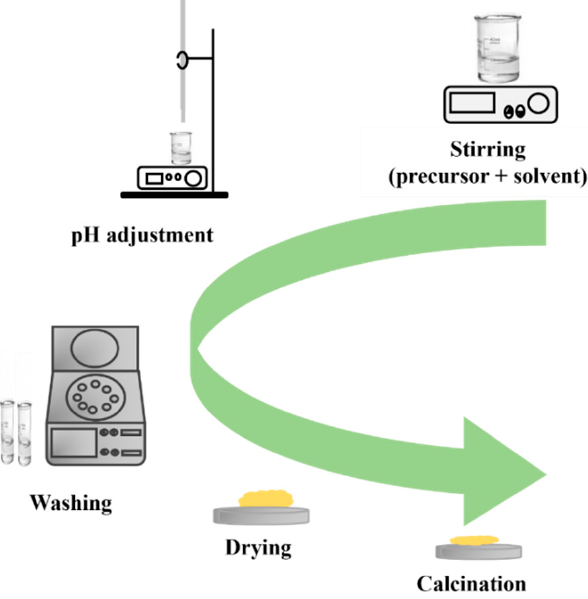
Figure 14. Diagram illustrating the steps of the precipitation method.